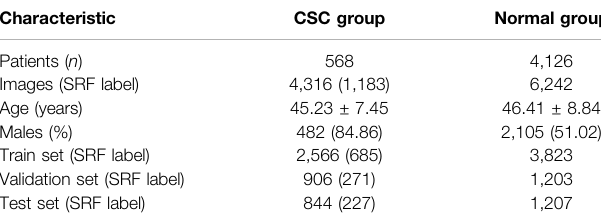
TABLE 1 | Patient demographics.